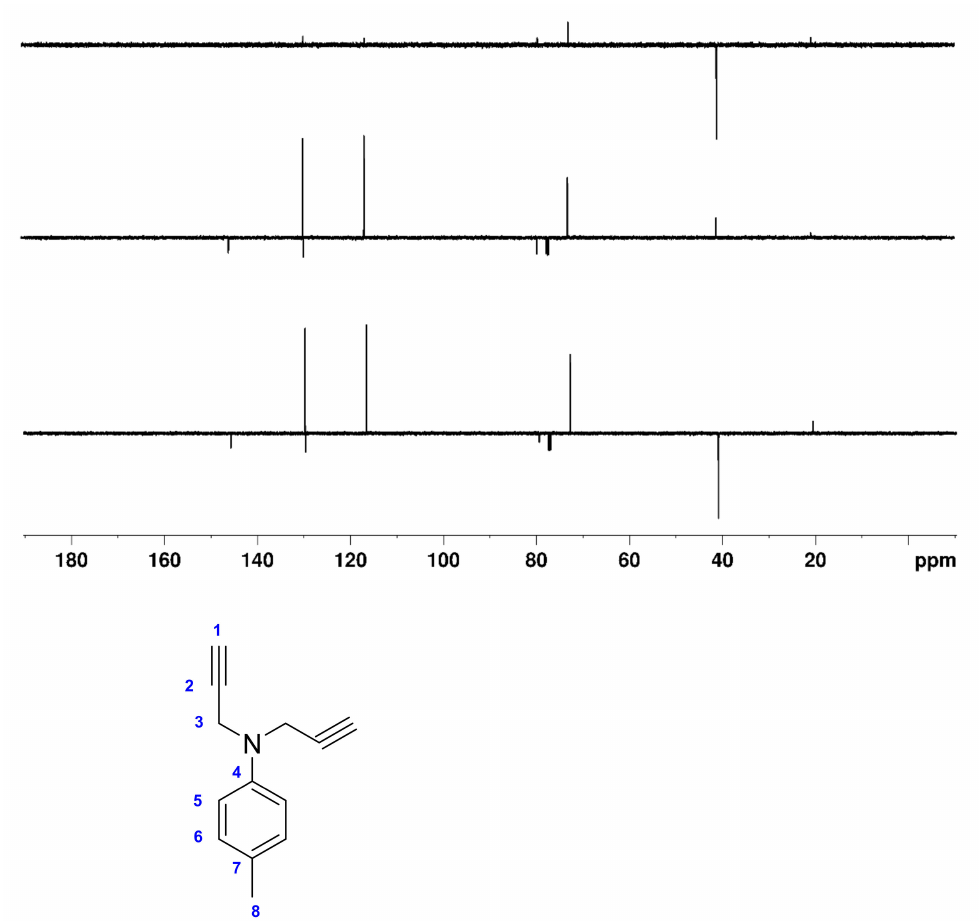
Figure 6. Bottom : DEPTQ135 90 , middle : DEPTQ90 45 ; top : Difference between DEPTQ135 90 and DEPTQ90 45 spectra of ~30 mg of 4-methyl- N,N -di(prop-2-yn-1-yl)aniline dissolved in 0.7 mL CDCl 3 . The delay δ was set to 2.70 ms, adjusted for a coupling constant 1 J CH of 185 Hz. The relaxation delay was 4 s, the NOE building period 3 s. All other parameters are identical to those described in the Materials and Methods section. The structure of 4-methyl- N,N -di(prop-2-yn-1-yl)aniline and carbon numbering is shown below the